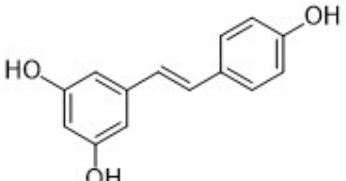
Figure 11. Chemical structure of resveratrol